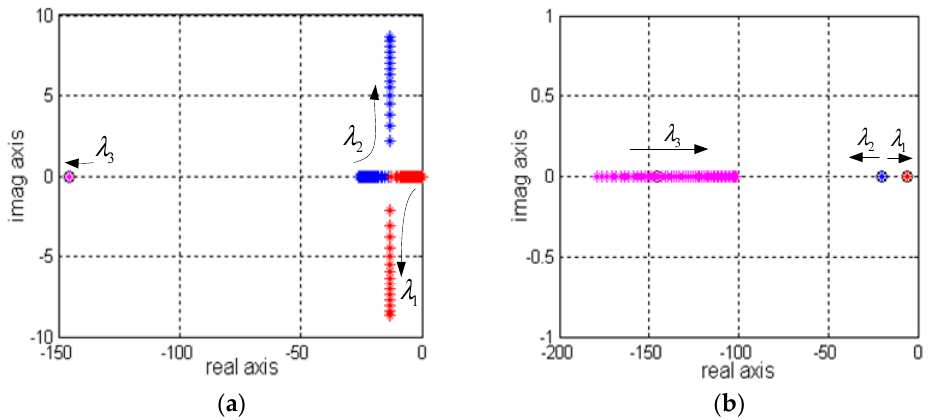
Figure 5. Small-signal model root trajectories with parameters variations. ( a ) Root trajectories when k Q_i is varied from 0 to 1 × 10 − 2 ; ( b ) Root trajectories when k P_d is varied from 0 to 1 × 10 − 7 .